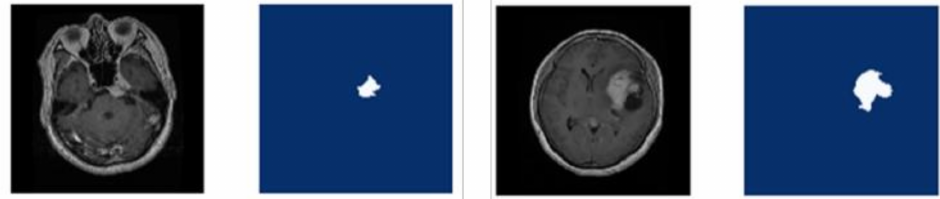
Figure 2. Sample original images and corresponding ground truth